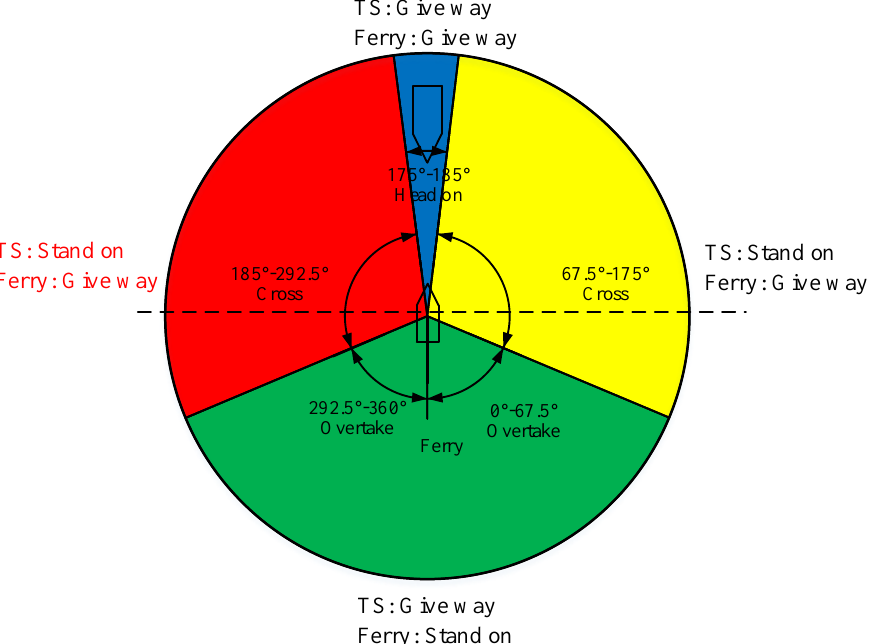
Figure 2. Responsibility of four encounter scenarios according to COLREGs and inland rules.